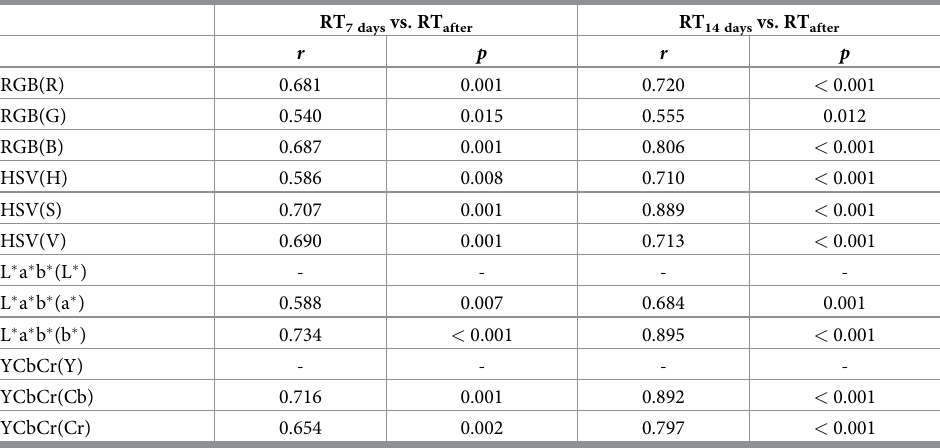
Table 6. Correlation coefficients ( r ) with corresponding p -values for Spearman’s rank correlation test between the values of color space parameters at approximately 10 days after finishing radiotherapy (RT after ) and those at approximately 7 days after the first fraction of radiotherapy (RT 7 days ) and at RT 14 days . RT 7 days vs. RT